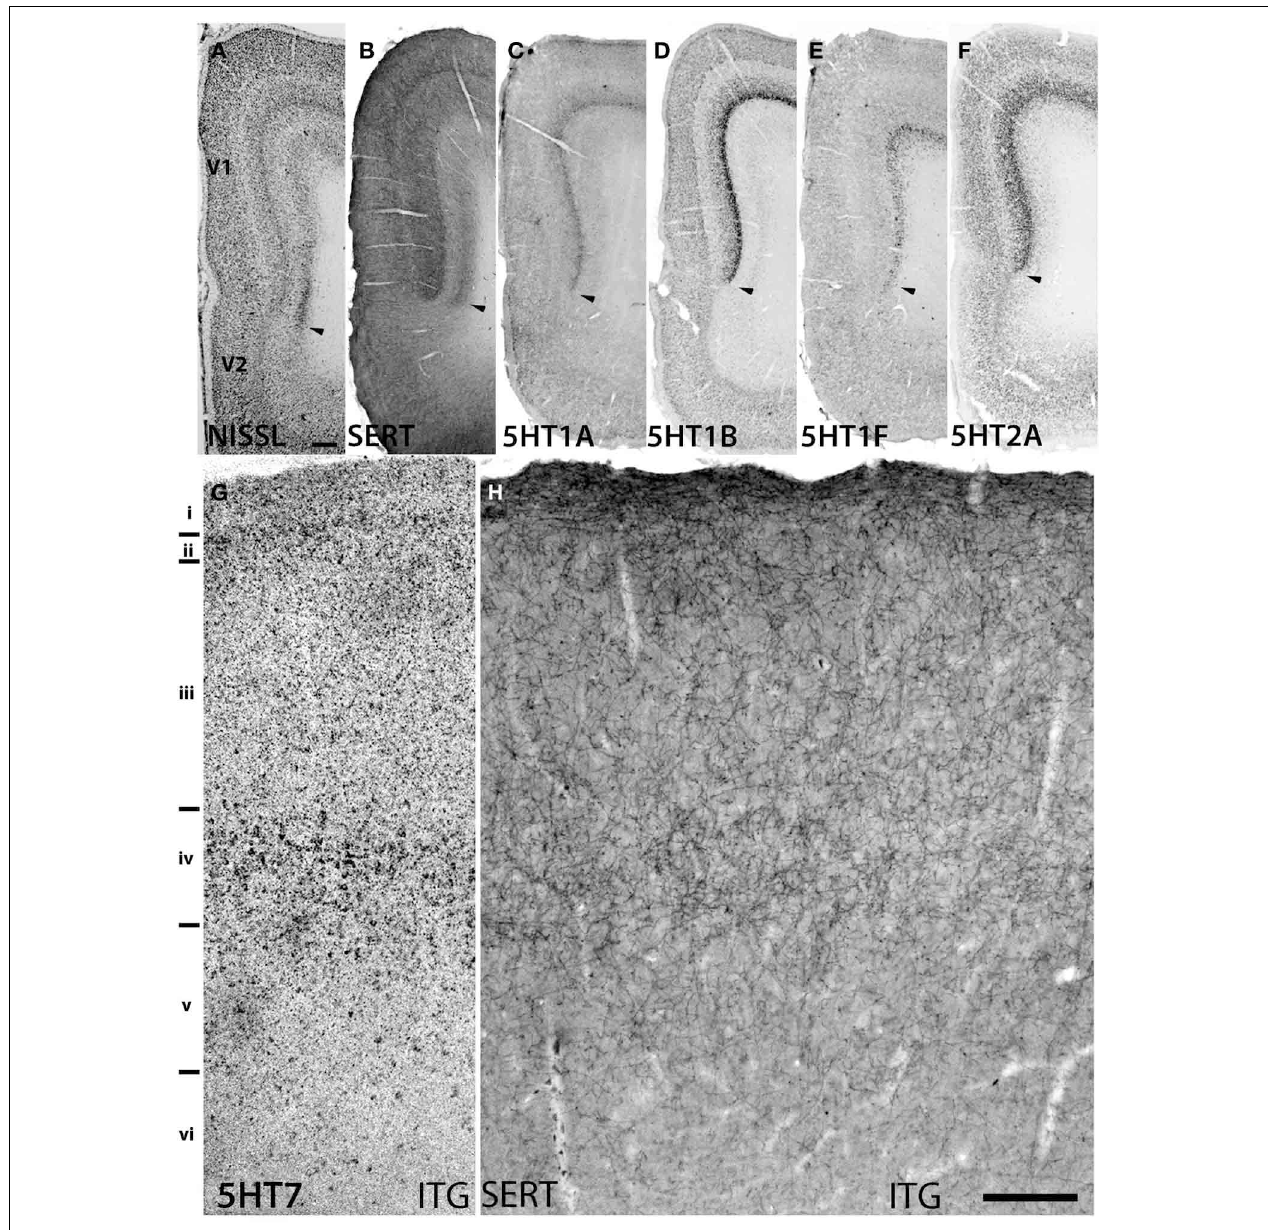
FIGURE 3 | Sections showing specific staining at V1 and V1-V2 border (A–F) and ITG (G,H). (A) Nissl staining and architecture of V1-V2. (B) Immunohistochemical staining with anti-SERT antibodies. Note that the projection density is particularly high in layers IV and VI. (C – F) Expression profiles of 5HT1B , 5HT2A , 5HT1A , and 5HT1F . The arrow heads indicate the